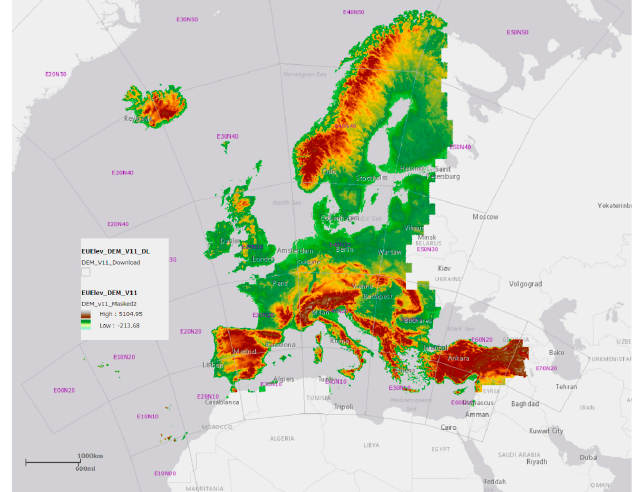
Figure 4. The spatial coverage of the tiles available in EU-DEM v1.1, along with a preview of the data. Source: EU-DEM v1.1—Copernicus Land Monitoring Service [55]. DEM data download service is available through the Polish Geoportal service; it en- ables the download of DEM data available in the Polish Central Geodetic and Carto- graphic Resource ( pol. Centralny Zasób Geodezyjny i Kartograficzny ) [56]. The data are pro- vided in the form of tiles that correspond to the extent to the PUWG 1992 coordinate sys- tem at a scale of 1:5000. Text files containing the elevation value of points in a regular grid with a mesh of 1 m were interpolated from the point cloud from laser aerial scanning (LIDAR). The resolution (horizontal accuracy) is approximately 1 m, while the average height error (vertical accuracy) is approximately 0.1 m. Data are available for free through the Polish Geoportal and are only available for the territory of Poland. The spatial coverage of tiles available for download is shown in Figure 5.